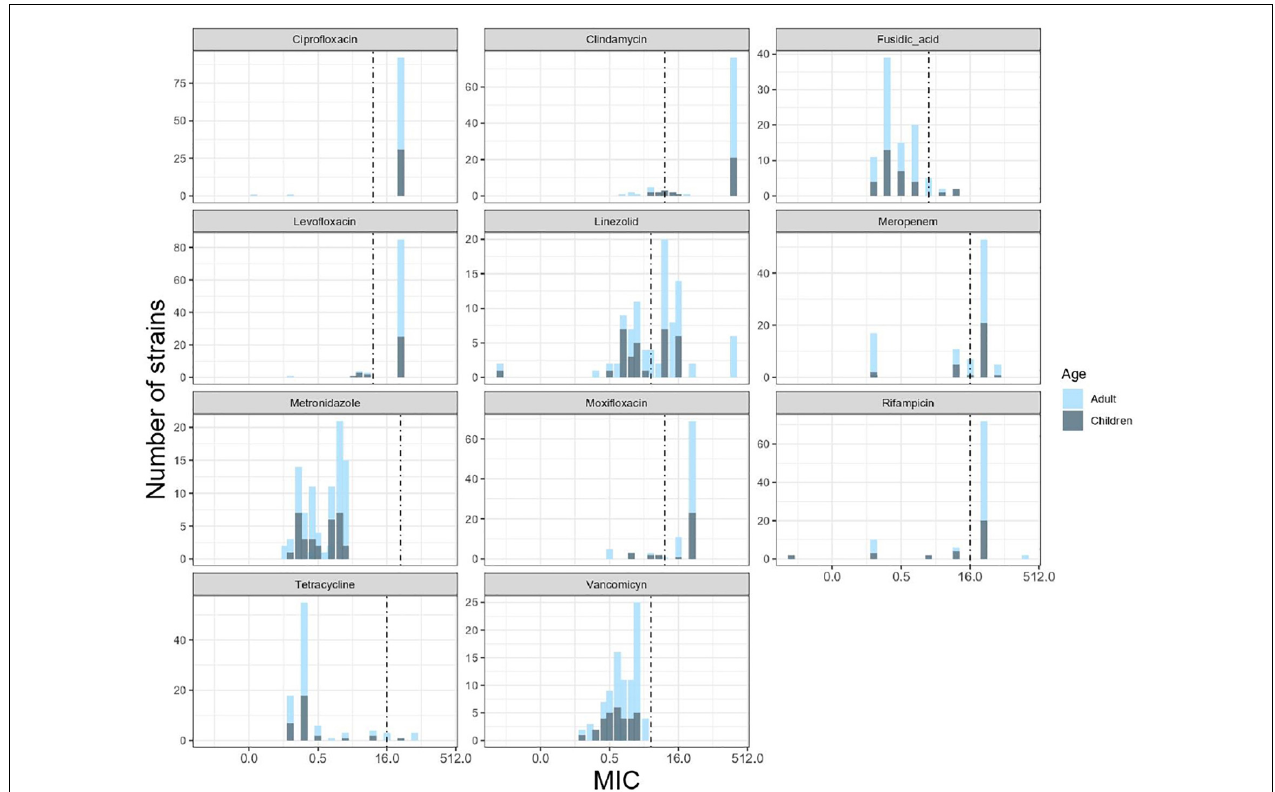
FIGURE 2 | Minimum inhibitory concentration (MIC) distributions for 11 antibiotics against 94 C. difficile isolates of children and adults. The graphs show the number of isolates across a range of MIC values. Black dashed lines indicate the clinical breakpoints according to the European Committee for Antimicrobial Susceptibility Testing